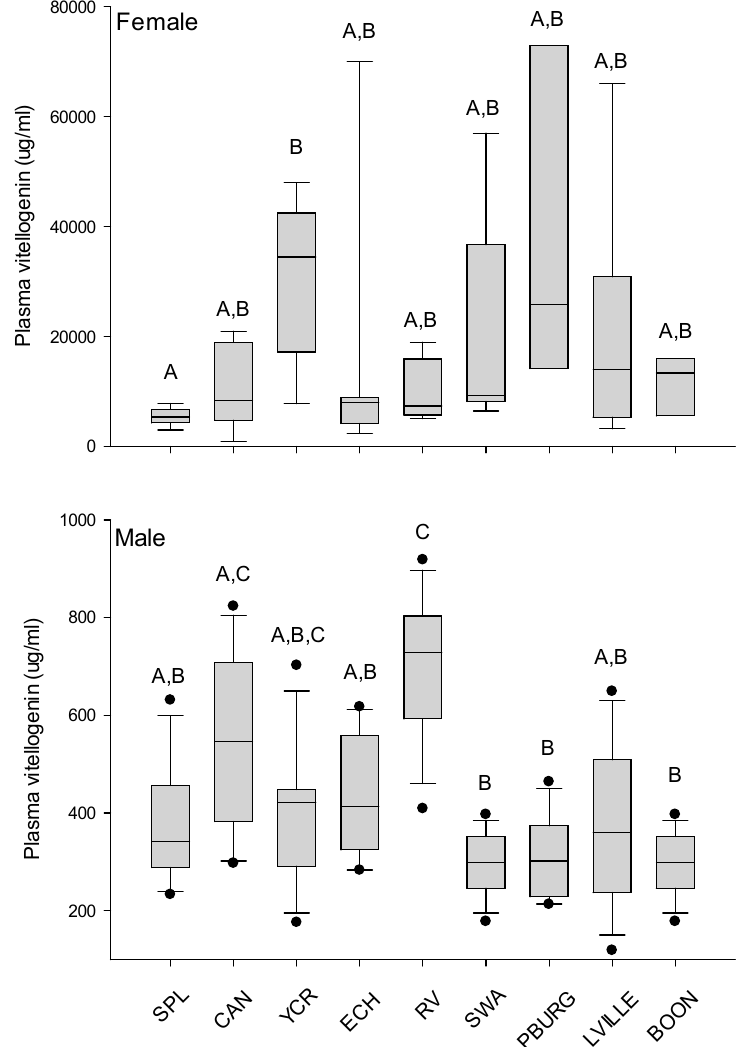
Figure 3. Plasma vitellogenin in female and male smallmouth bass collected in New Jersey during the spring of 2017. Sites are ordered along the x-axis based on decreasing intersex severity observed in male fish. Box and whisker plots with 95% confidence intervals. Black dots indicate outliers. Bars denoted with different letters indicate statistically significant differences ( α = 0.05). Site abbreviations are defined in Table 1.